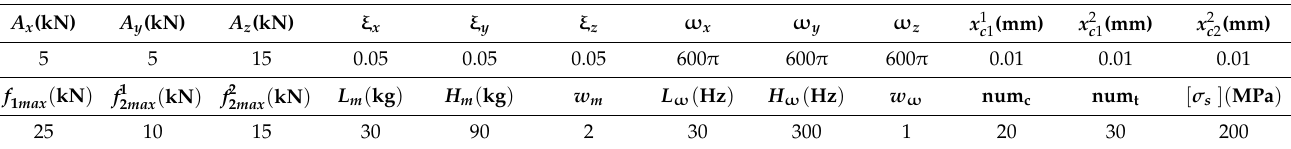
The buffer force magnitude f 1 in the main strut is the function of buffer stroke x . Their relationship is shown in Figure 9a. The x axis is the main strut buffer stroke. It is the relative translation distance between nodes u O 1 and u I 1 , which are expressed in local coordinates.